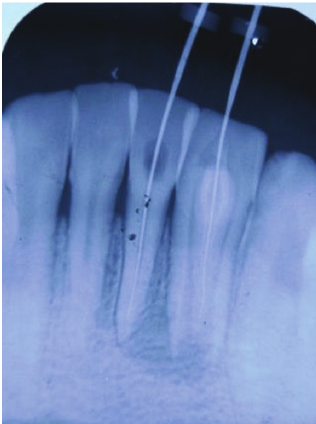
Figure 8: Root canal of 31 and 32 obturated with GP along with GIC lining in relation to 32 (dentinal wall) and completed healing of PA